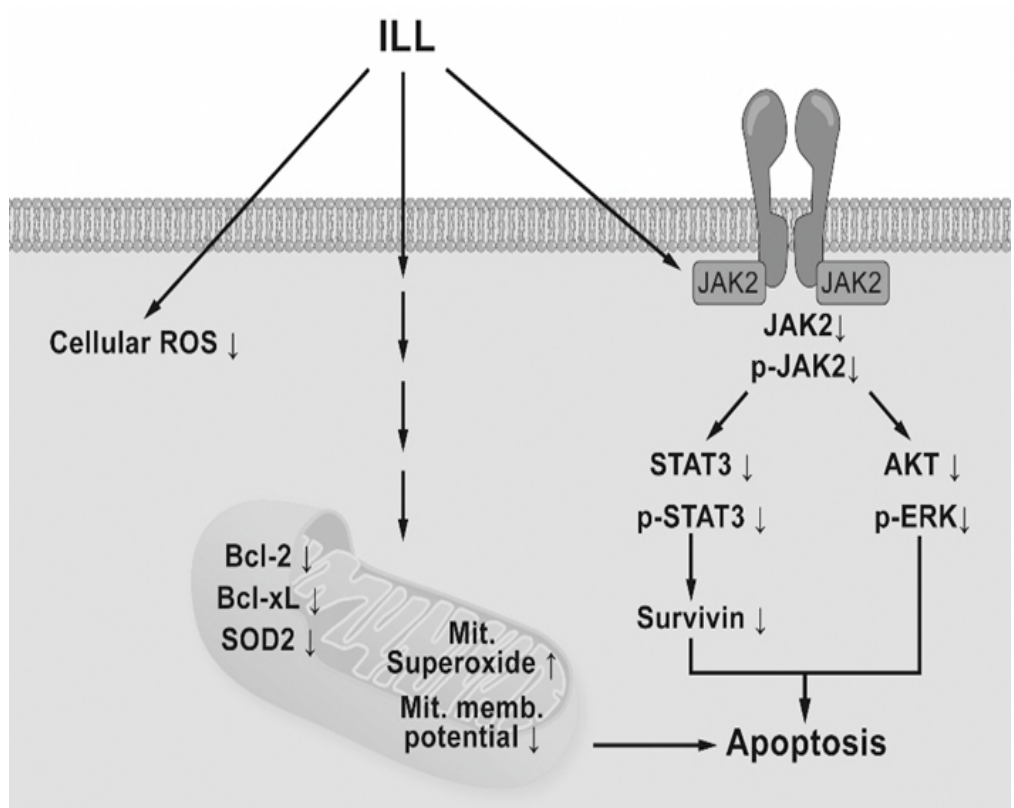
Figure 6. Schematic diagram of ILL ‐ induced cell death. ILL induces generation of mtSO and decreases MMP in both cells through reduction of Bcl ‐ 2, Bcl ‐ xL, and SOD2 expression. On the other hand, ILL declines in expression and phosphorylation of STAT3 and survivin, a STAT3 ‐ regulated gene during cell death.